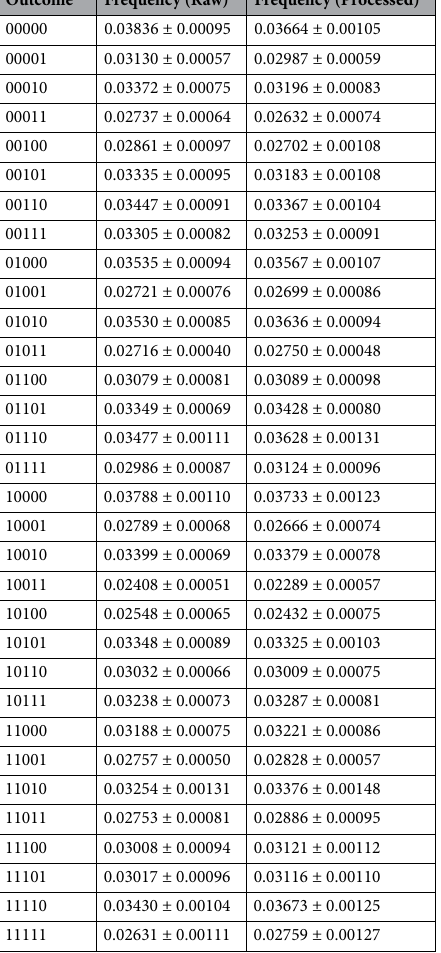
Table 2. Relative frequencies with which the 32 random unitaries, corresponding to the 32 different measurement outcomes, are generated with the exact 3-design on the ibmq_toronto quantum processor. ‘Raw’ shows the relative frequencies without quantum readout error mitigation. ‘Processed’ shows the relative frequencies with quantum readout error